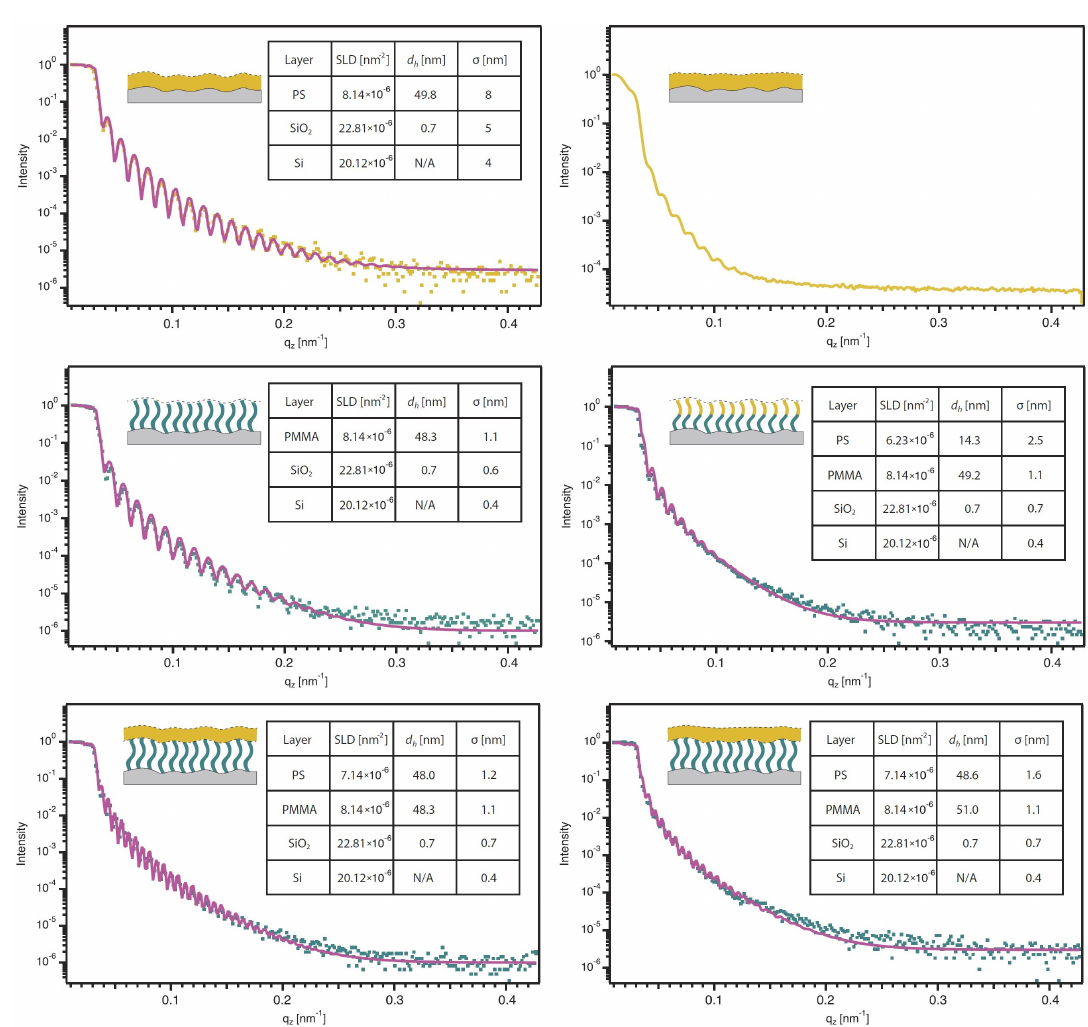
Figure 9. X-ray reflectivity curves of polymer thin films. Measuring points are displayed as dots and fits are presented as solid lines. Note that the measurement for the spin-coated PS film after annealing could not be fitted, as the sample could not be adjusted properly. Via curve fitting procedure, scattering length density (SLD), dry layer thickness ( d h ) and RMS roughness ( σ ) could be